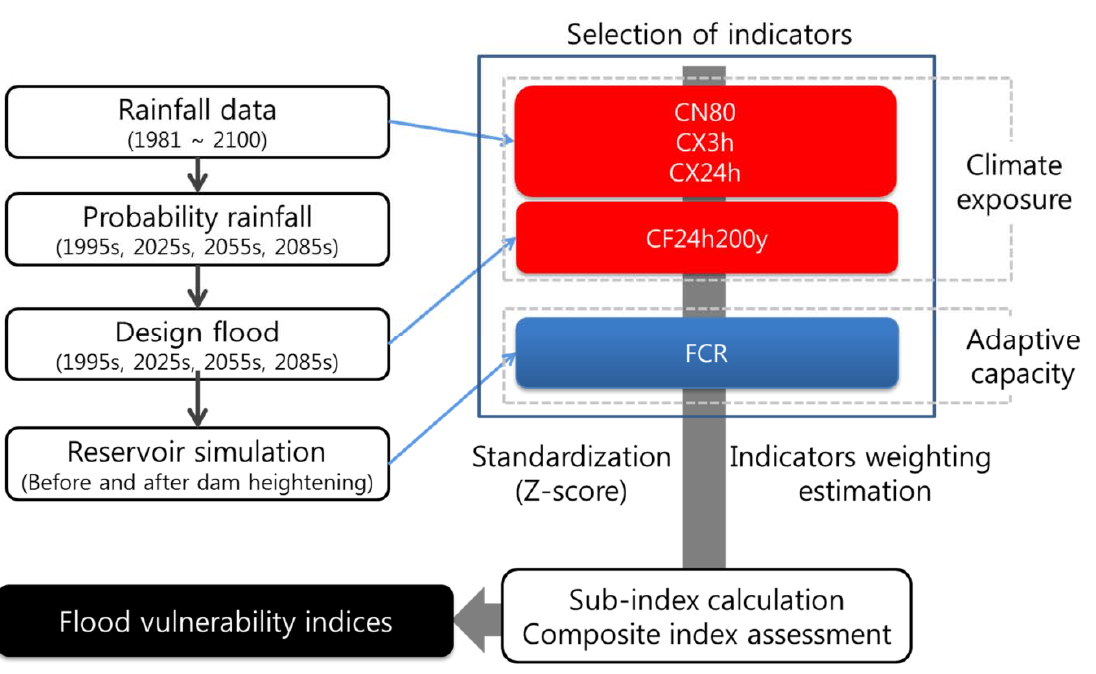
Table 1. Indicators for climate exposure and adaptive